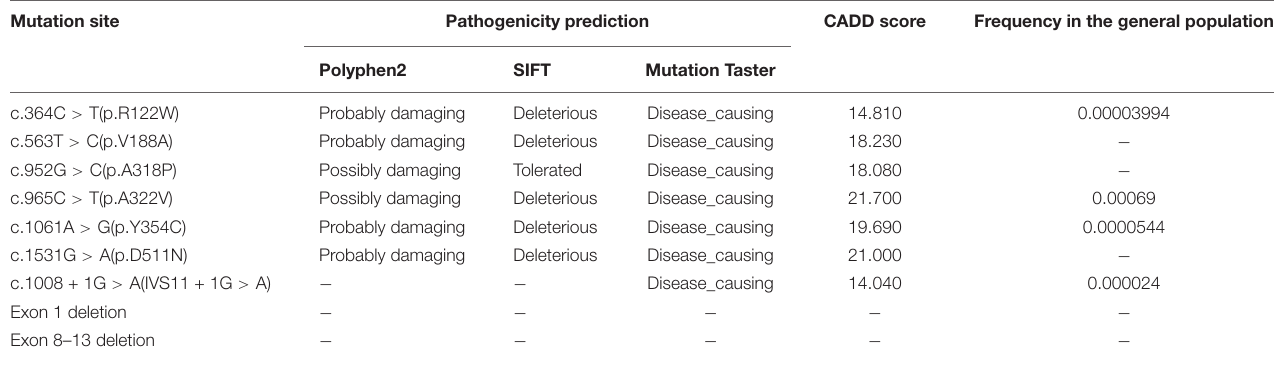
TABLE 2 | Details of molecular variants of ALDH7A1 (NM_001182.4) identified in six affected sibling